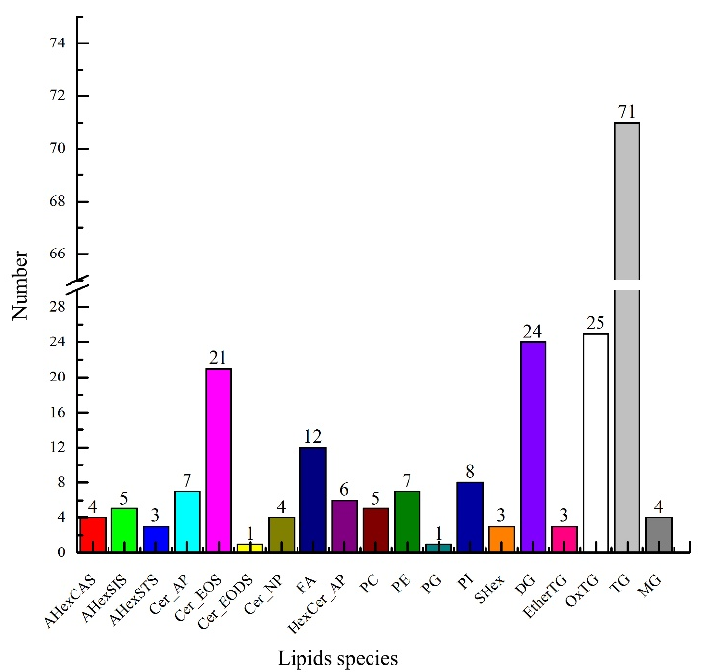
Figure 2. Lipid species in green coffee. Table 1. Composition of the 214 lipids in green